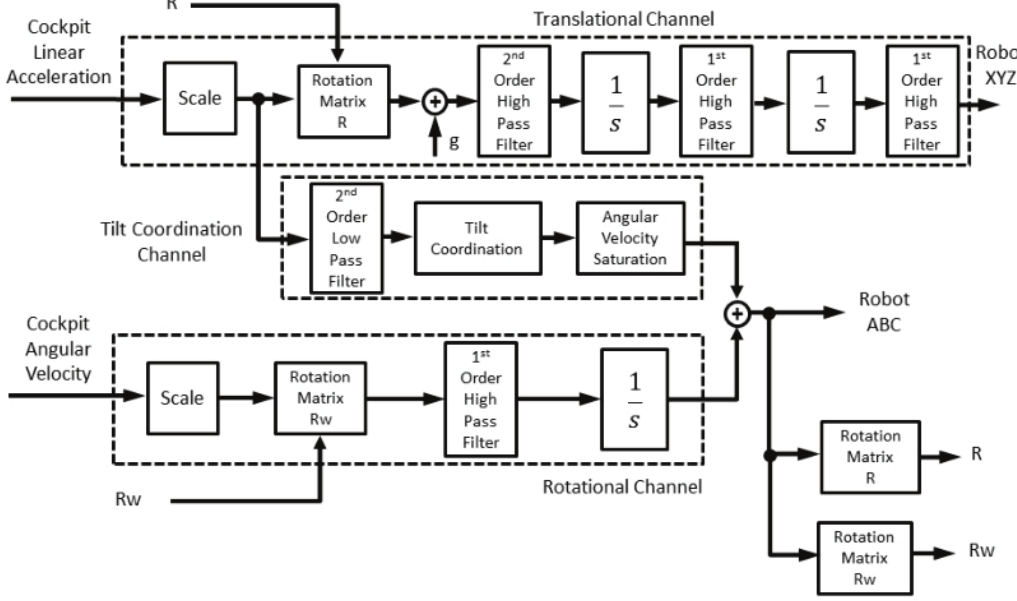
Figure 4. Block diagram of the classical washout filter as proposed by Schmidt and Conrad